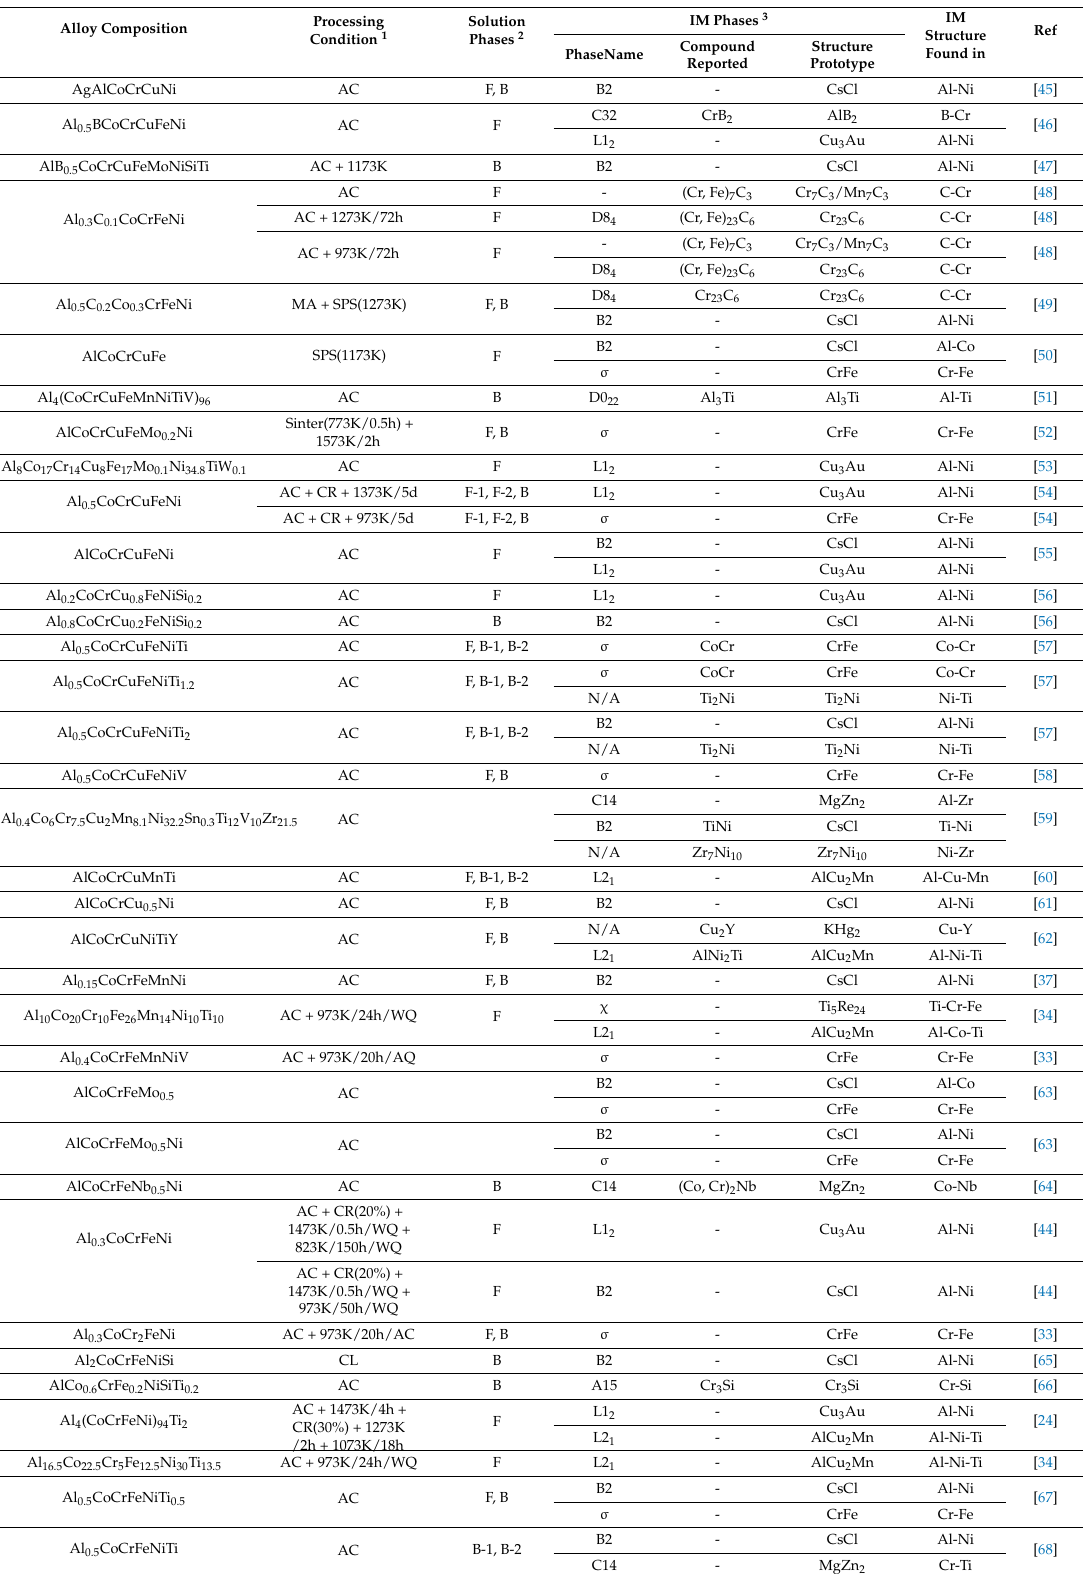
Table 1. Composition, processing condition, phase constituents, and structural inheritance of the 142 IM-containing HEAs considered in this